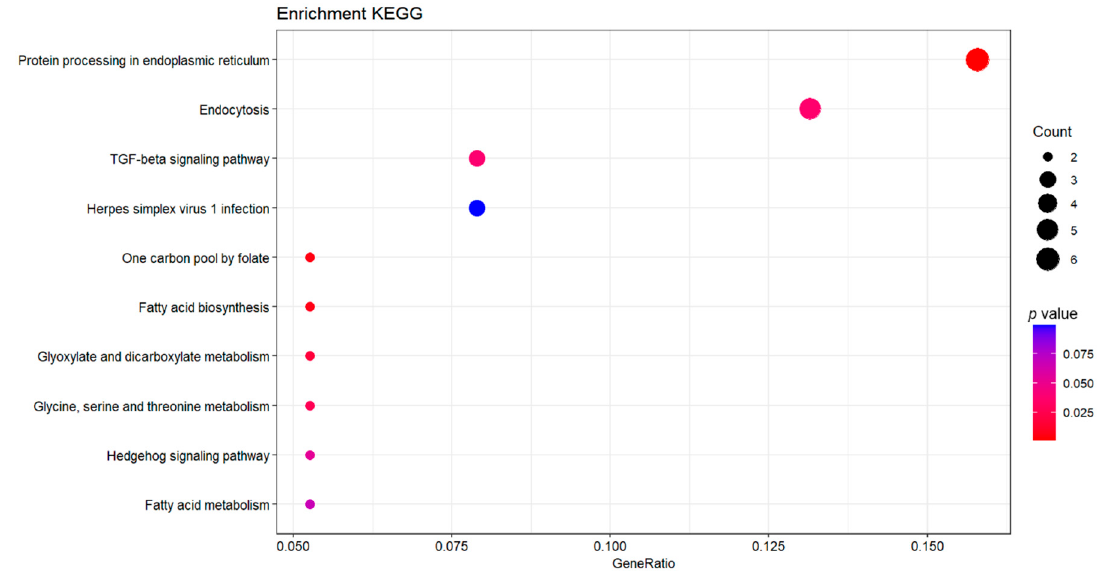
Figure 3. KEGG enrichment